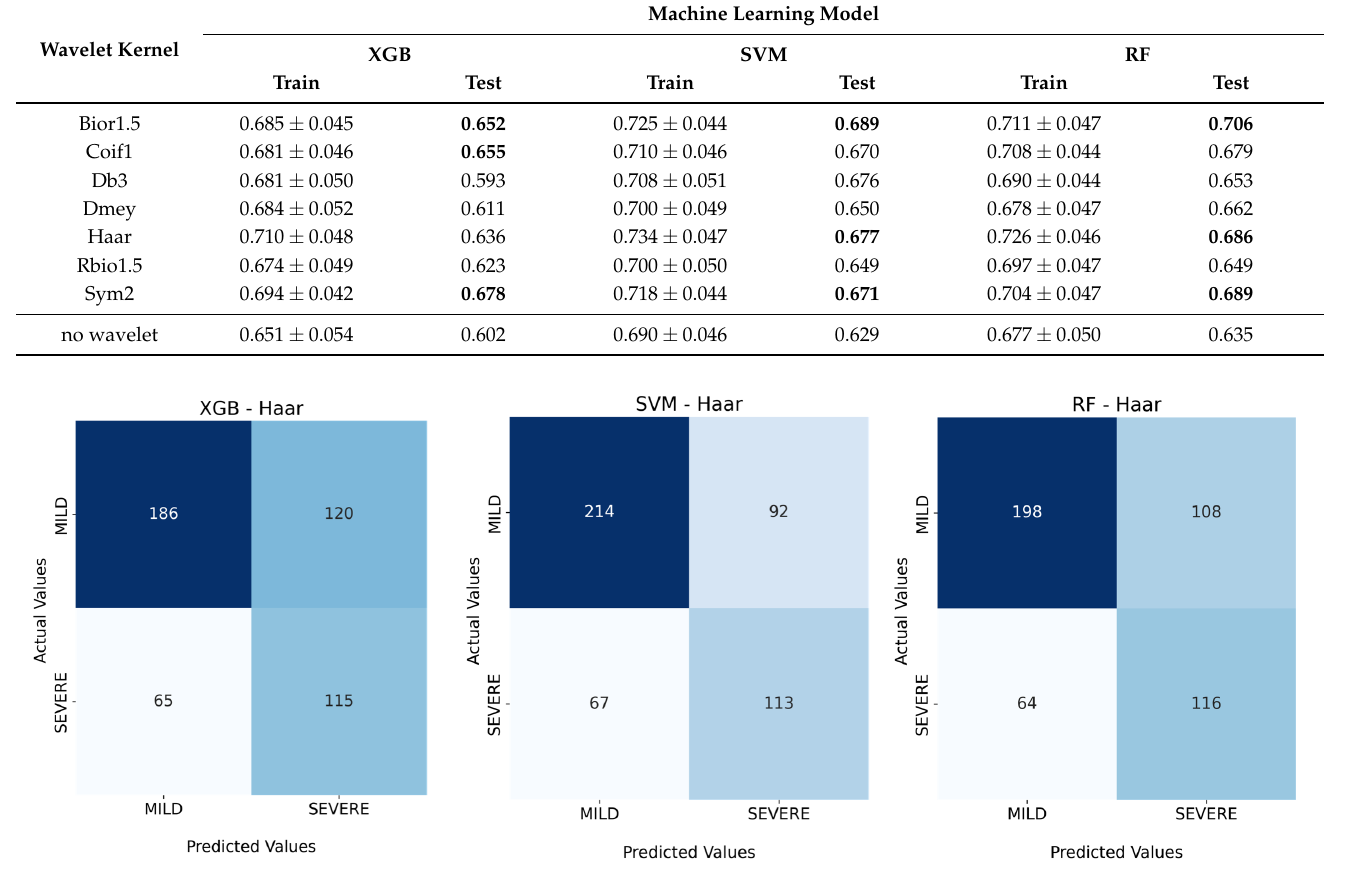
Figure 3. The confusion matrices of the three ML classifiers obtained with the Haar